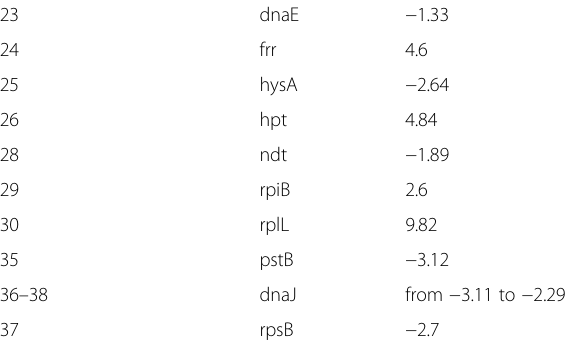
Table 3 Protein ratio of liposoluble (A) and hydrosoluble (B) fraction of Mycoplasma fermentans. The ratio MFI anaerobic versus MFI aerobic is shown